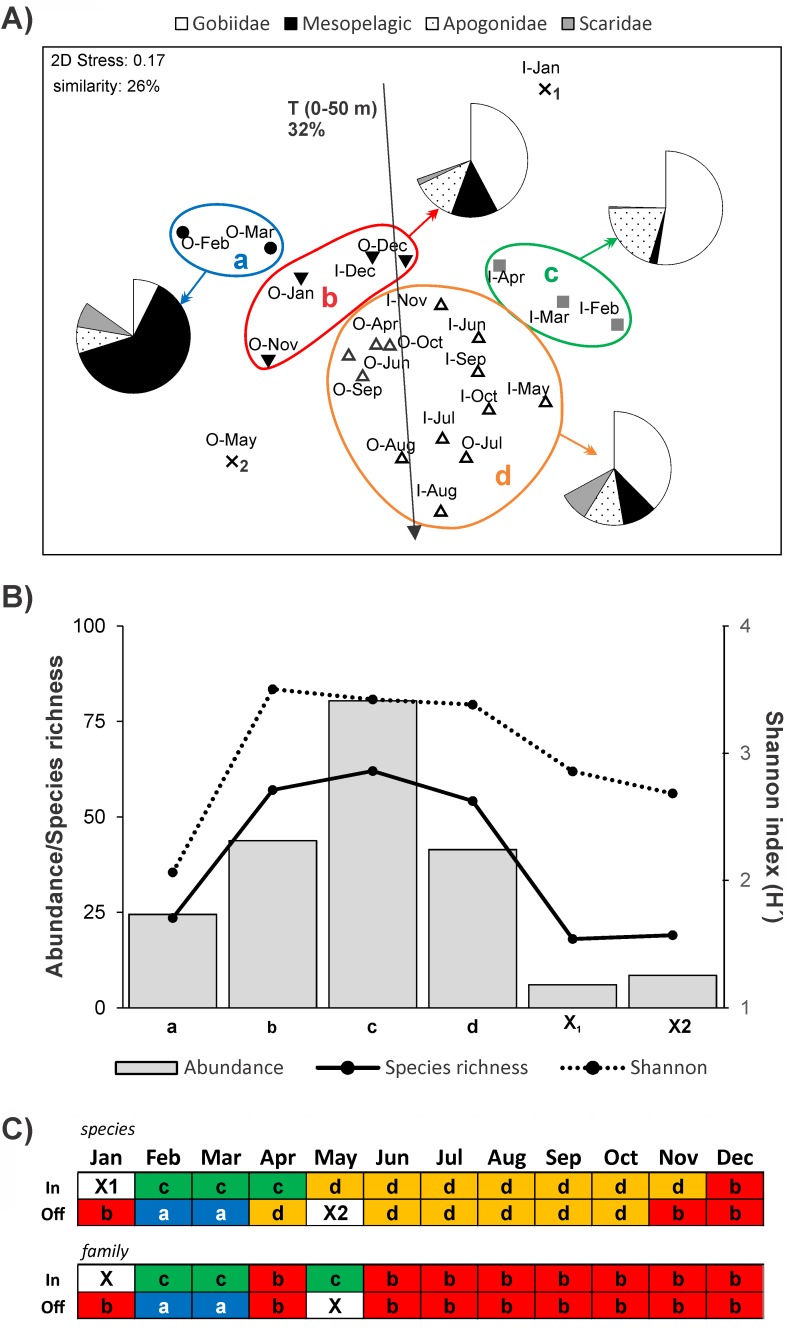
Grouping of samples based on larval fish community structure.(A) Ordination plot of the comparison between samples (I: inshore, O: offshore) using non-metric multidimensional scaling and Bray–Curtis similarity index. Cluster groups a-d identified at 26% similarity level are superimposed and mean relative contribution of major taxa (Gobiidae, Mesopelagic families, Apogonidae, Scaridae) in each group is presented in pies (missing part of the pie corresponds to remaining families). Significant multiple regression between ordination scores and average temperature at the sampling layer is shown, as well as the fraction (%) of variance in the fish larval data explained by this parameter. (B) Average larval abundance, species richness and Shannon’s index for the groups of samples identified by the cluster analysis (Groups a-d) (C) Schematic representation of cluster of samples based on species and family composition.